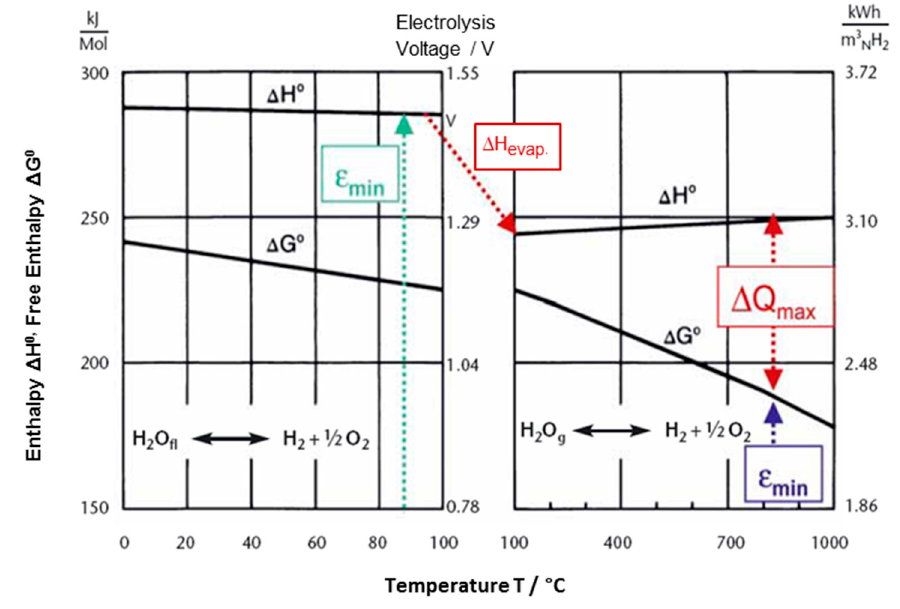
Figure 5. Thermodynamics of the water splitting reaction as a function of temperature, reproduced with permission of Journal of Power Sources [6].